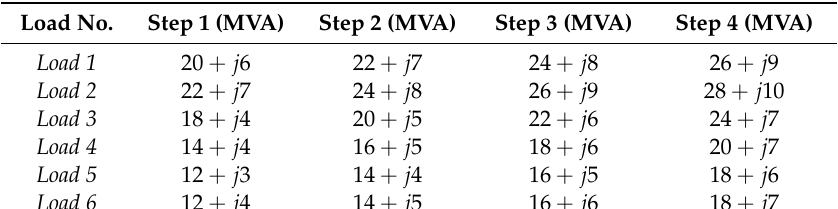
Table 1. Loads values for all steps.